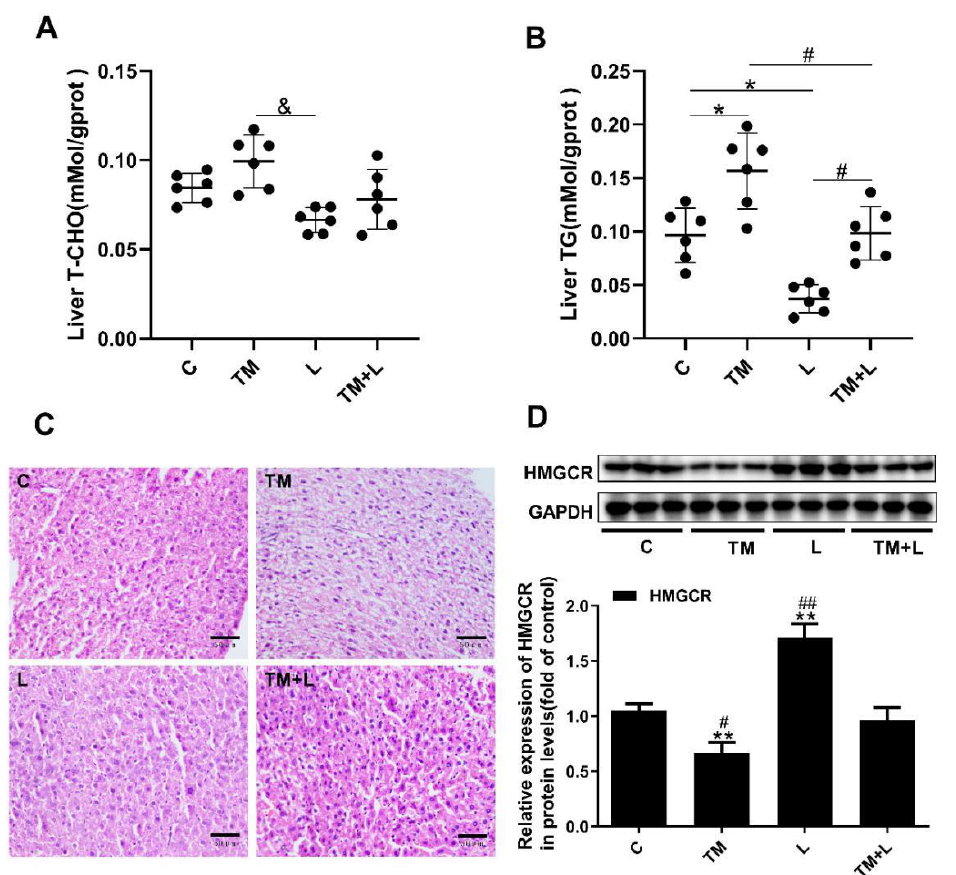
Figure 2. Tunicamycin-induced ER stress caused liver lipid accumulation, and LXR-623 had the opposite e ff ect. ( A ) Liver total cholesterol level. ( B ) Liver triglyceride level. ( C ) H&E staining of the liver. ( D ) Expression levels of HMGCR in the liver. C, control; TM, tunicamycin; L, LXR-623; TM + L, tunicamycin + LXR-623. Data are shown as the mean ± SD ( n = 6), * p < 0.05 or ** p < 0.001 versus the C group. # p < 0.05 or ## p < 0.001 versus the TM + L group. & p < 0.05 versus L group.